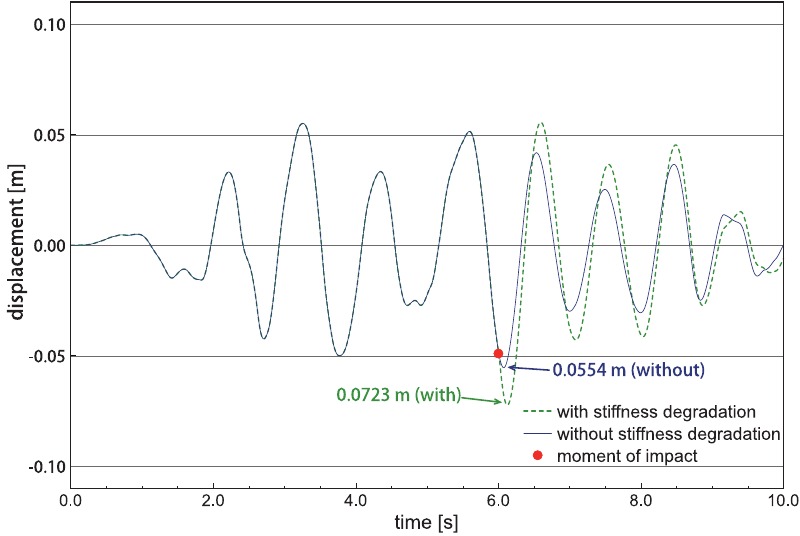
Fig. 10. Displacement time history of the first story of building under the El Centro earthquake with and without considering the degradation of horizontal stiffness for impact at t = 6 s.